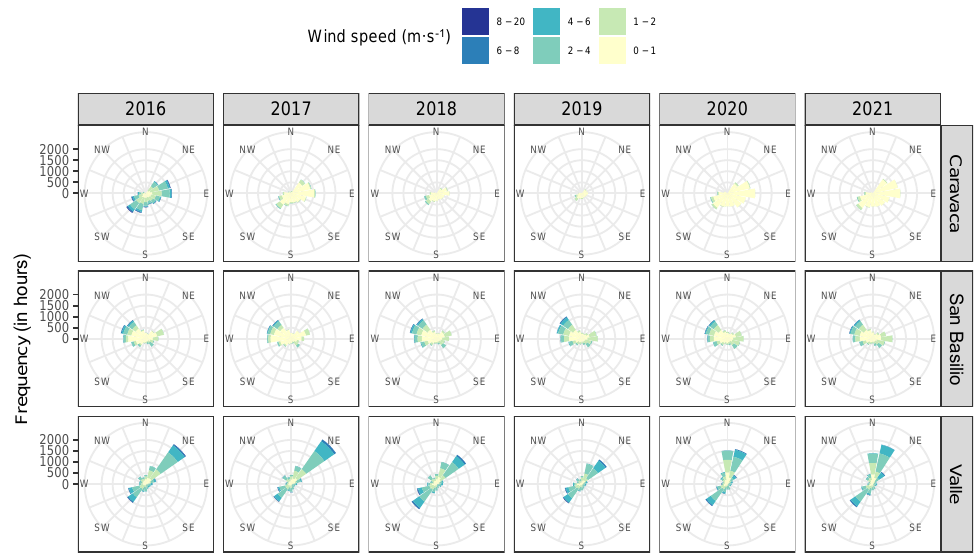
Figure 2. One-hour surface wind speed and direction data represented in wind rose plots at the three stations (Caravaca, San Basilio, and Valle).